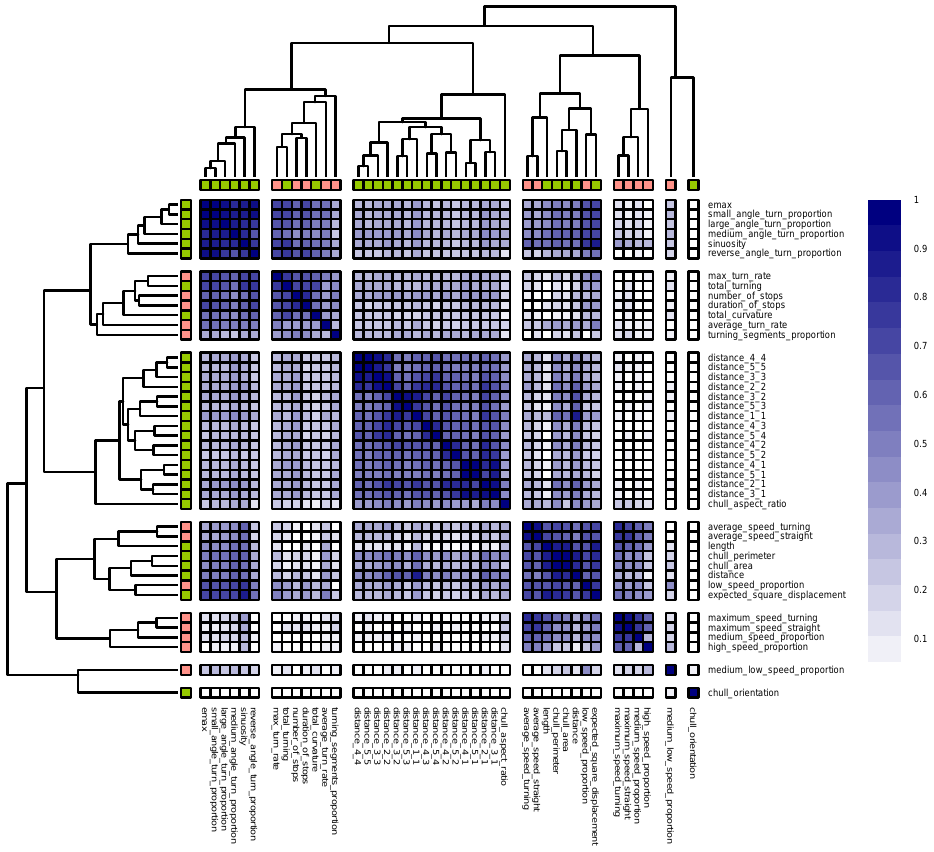
Figure 11. The hierarchical clustering of the similarity matrix for the hybrid problem: geometric predictors; kinematic predictors. The similarity index for a pair of descriptors is between 0 and